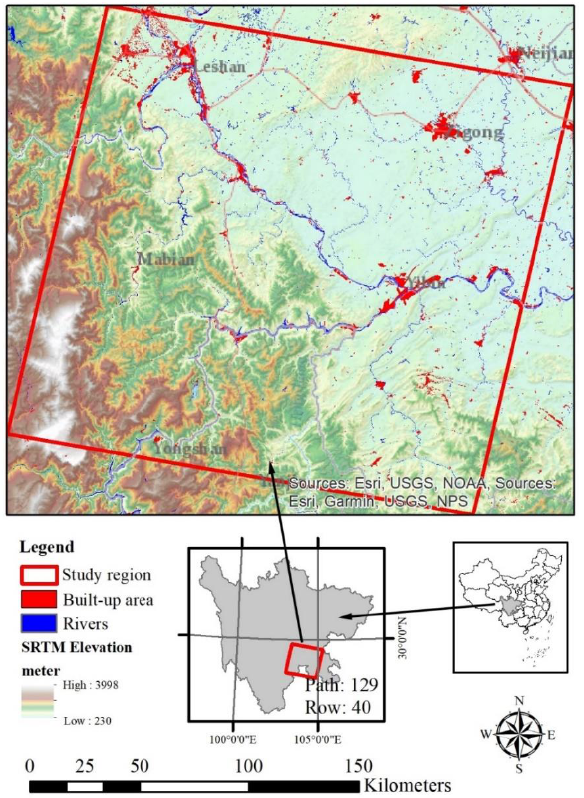
Figure 1. The study region is one Landsat footprint (WRS: Path 129/Row 40) covering Yibin City, Sichuan Province (grey) in China. Its topography consists of a mountainous region in the south-west and a hilly region in the north-east. Yibin city is situated in the convergence of Min River and Jinsha River. Table 1. List of land cover products and cropland maps used to obtain the union of